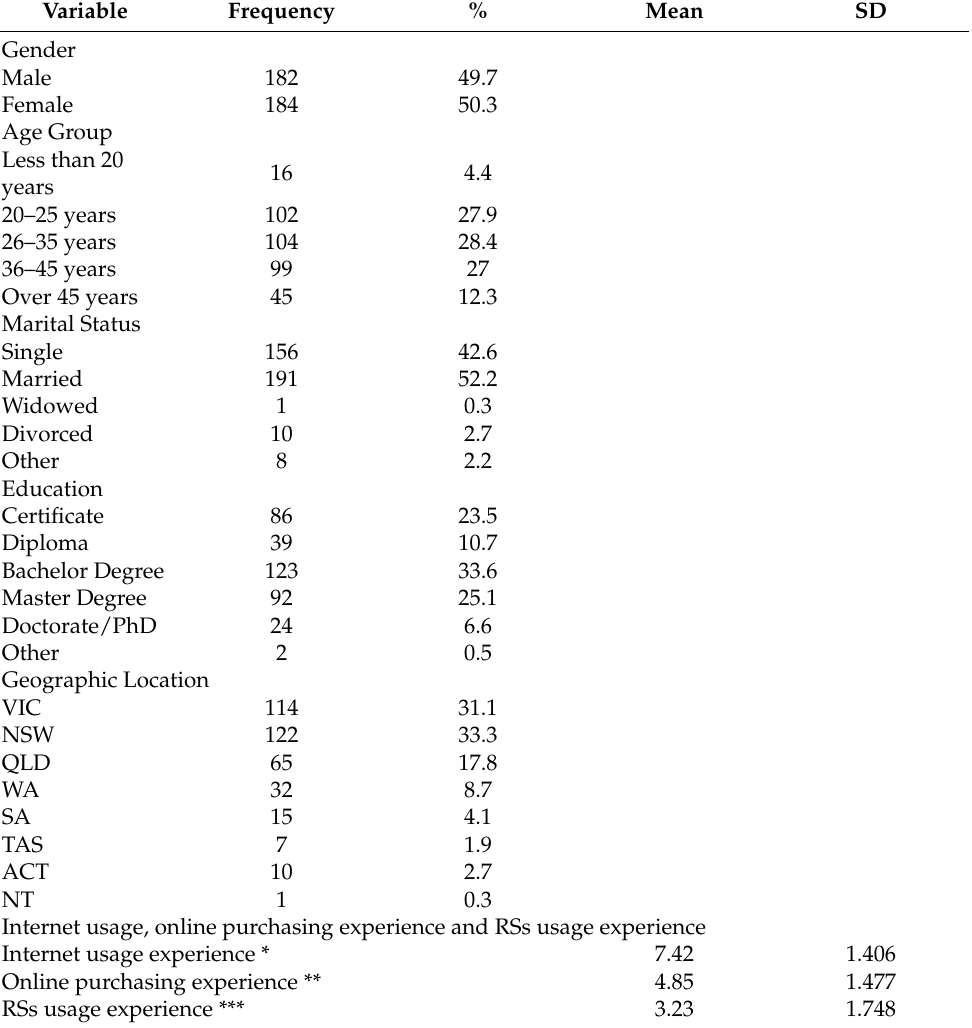
Table 3. Descriptive